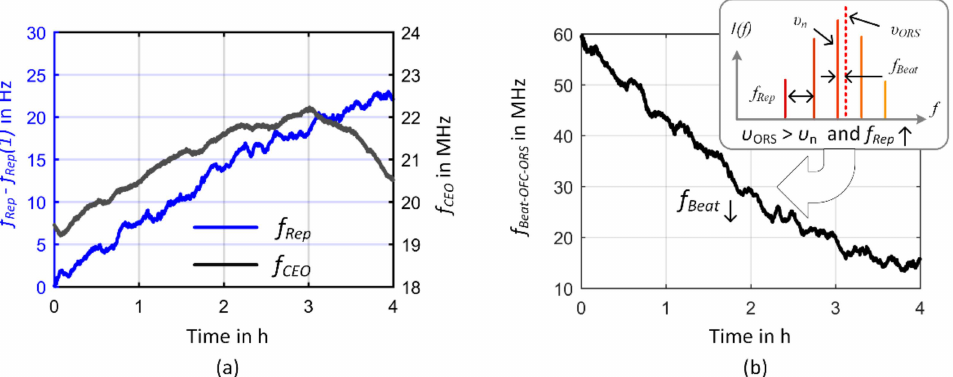
Figure 7. Frequency instability of the free-running comb. ( a ) Time traces of the free-running comb parameters measured with the FXM50. The left y -axis depicts the change of repetition rate from its initial value. The right y -axis the CEO. ( b ) Time trace of the beat note between the respective comb line and the ORS. Since the frequency υ ORS of the ORS lies above the respective frequency of the comb line υ n , an increase in the repetition rate f Rep results in a decrease of the beat frequency f Beat . To monitor the frequency changes of the beat note, the measurements were performed without the bandpass filter at 60